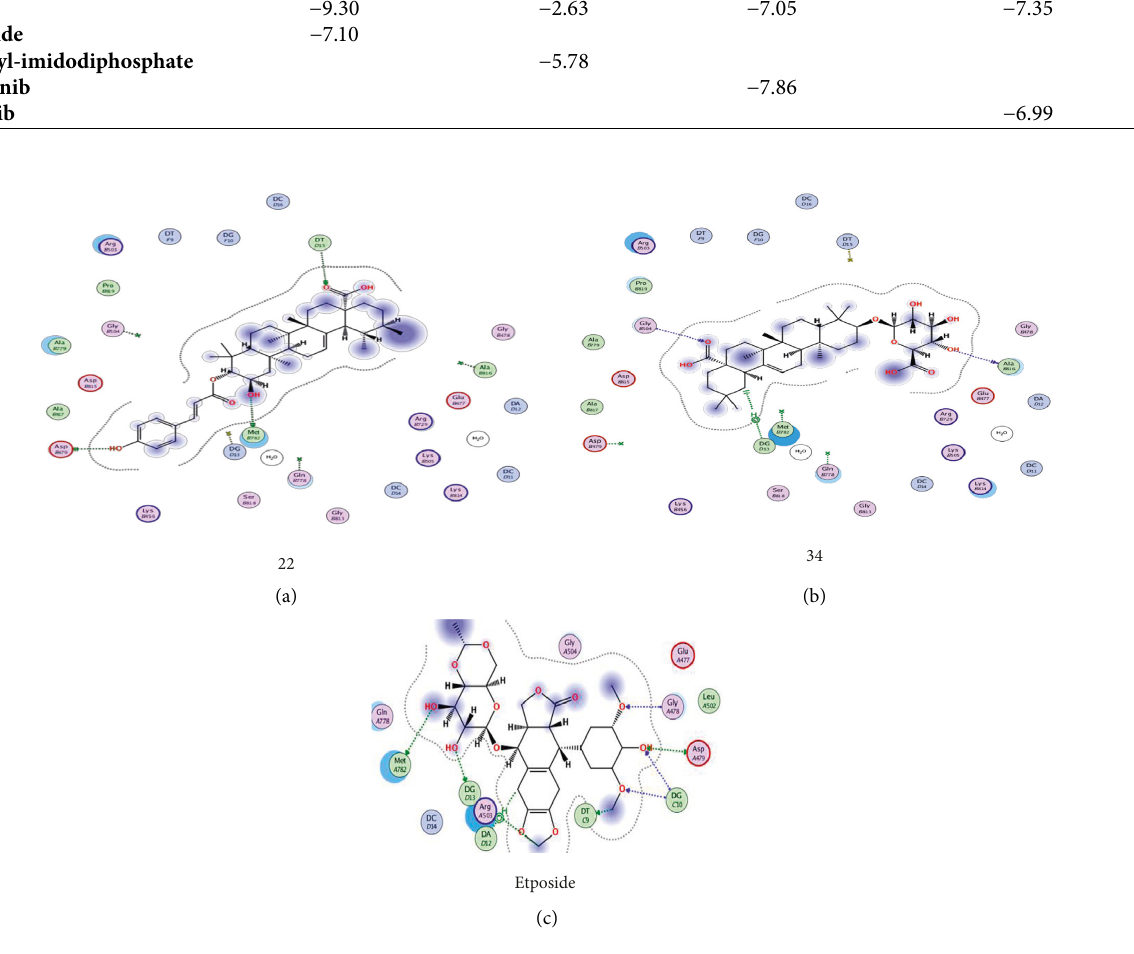
Figure 6: Docking of compounds (22) and (34) with topoisomerase.